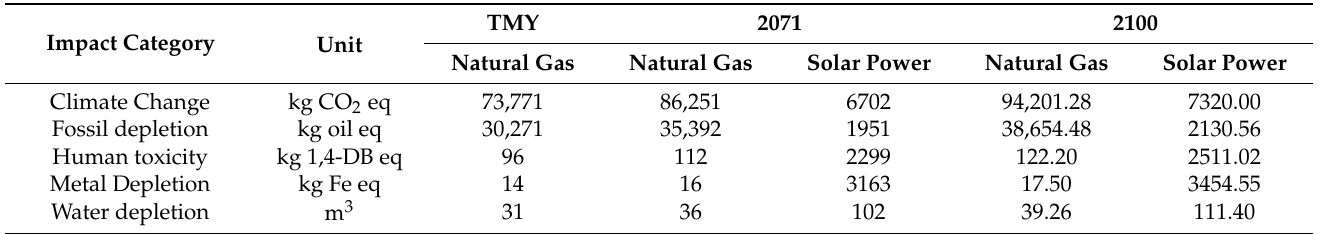
Figure 3. Impact results for energy production through natural gas and solar power. Table 6. The environmental impacts associated with the cooling demand for mid-rise apartments.